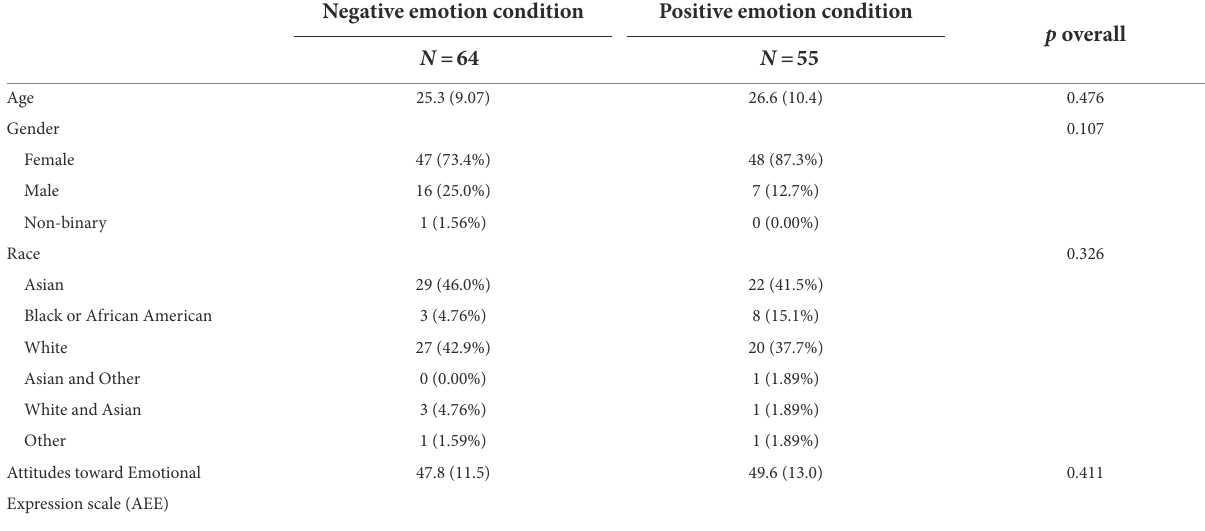
TABLE 3 Summary descriptives by experimental